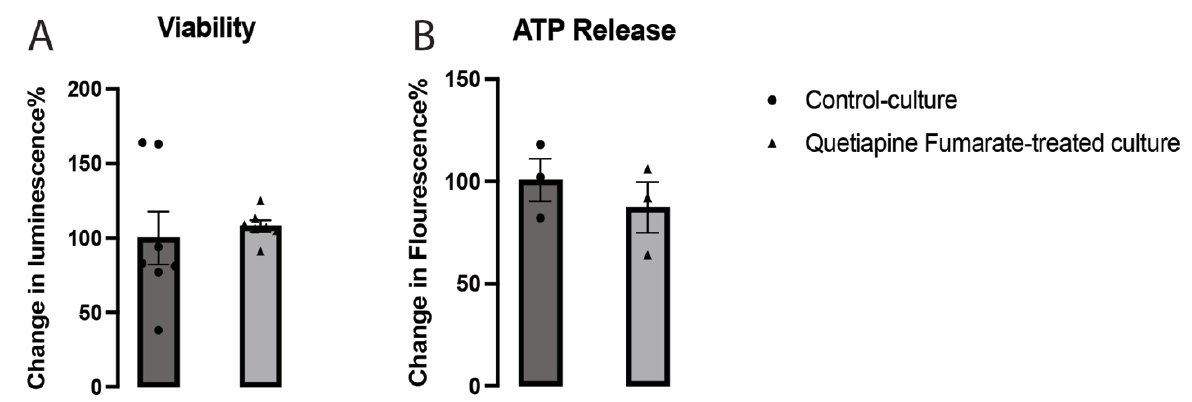
Figure 1. Quetiapine Fumarate (QEPF) did not significantly affect the viability ( A ) and ATP release ( B ) of VM neurons. Data expressed as mean ± SEM, n = 3 technical replicates, 7 biological replicates (Viability), and 3 biological replicates (ATP release).